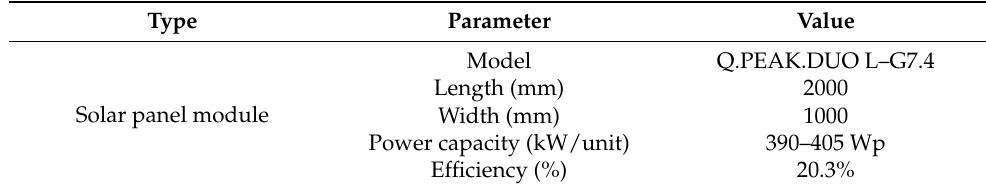
Table 2. Solar panel, Hanwha Q . CELLS’ Q.PEAK.DUO L– G7.4 390-405 model.